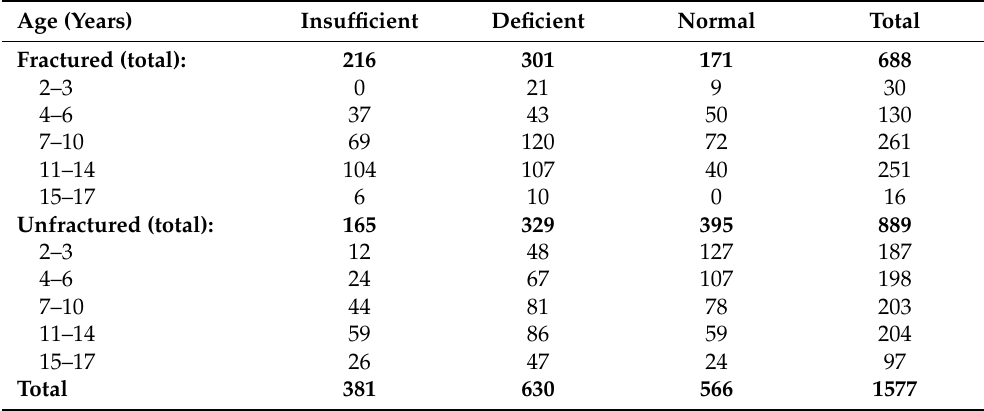
Table 5. Patient distribution according to fractured or unfractured group and, subsequently, according to their vitamin D levels (normal, deficient, or insufficient level). In bold, total number of patients based on serum category level.